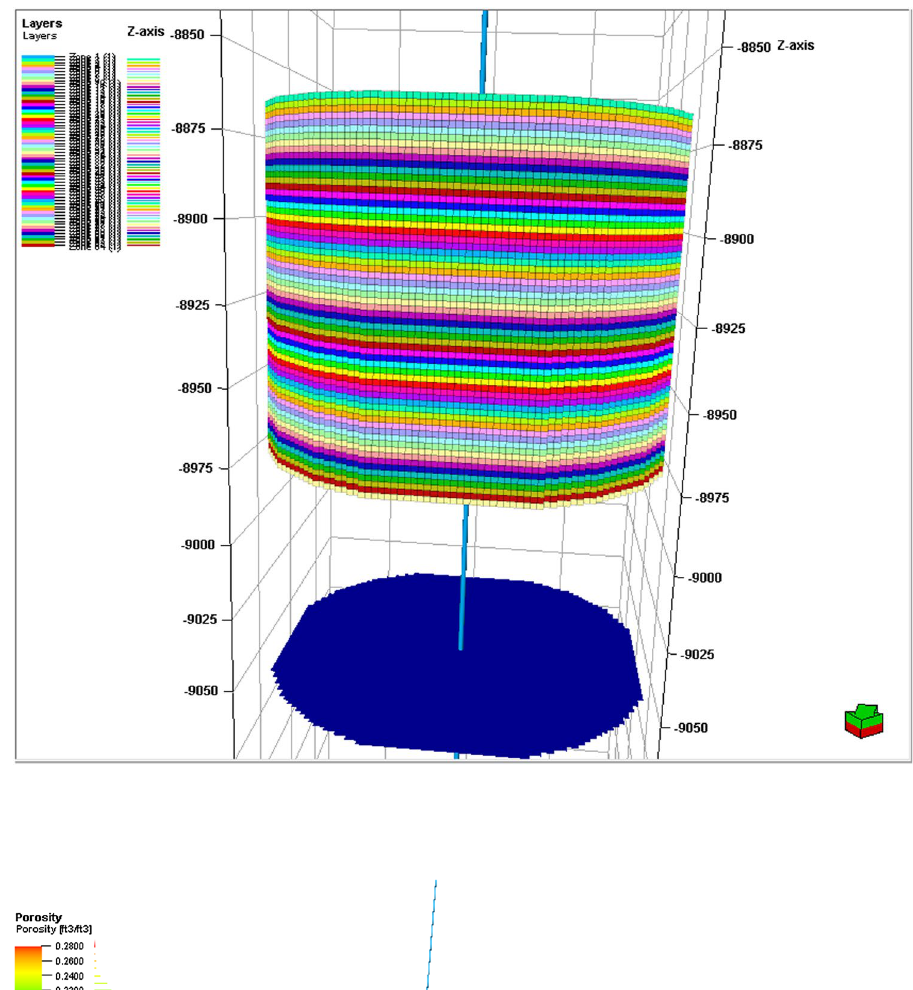
Fig. 18 Single well model showing different layering thickness